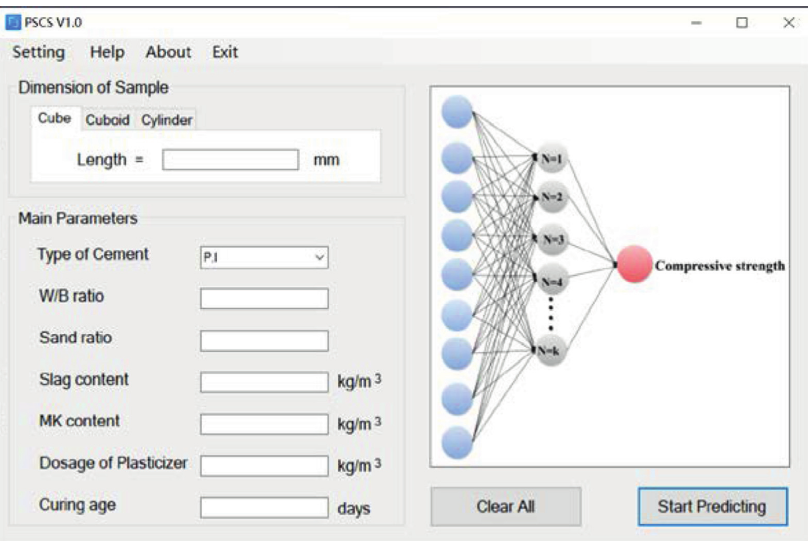
Figure 14: Interface for inputting